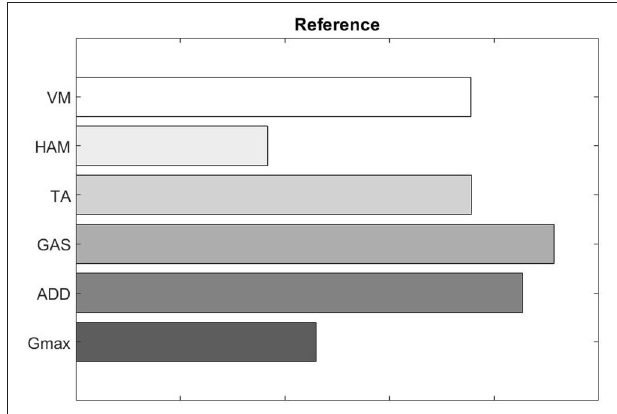
Frontiers in Neuroscience |